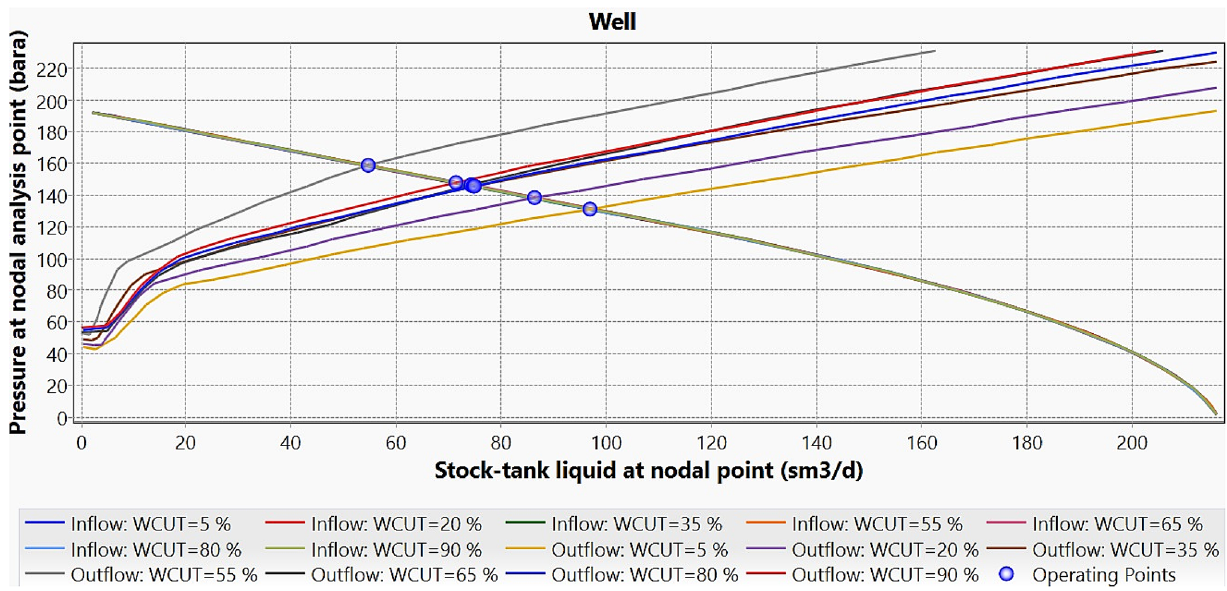
Fig. 3 The effect of an increase in water cut on the change in the liquid flow rate of the gas-lift well